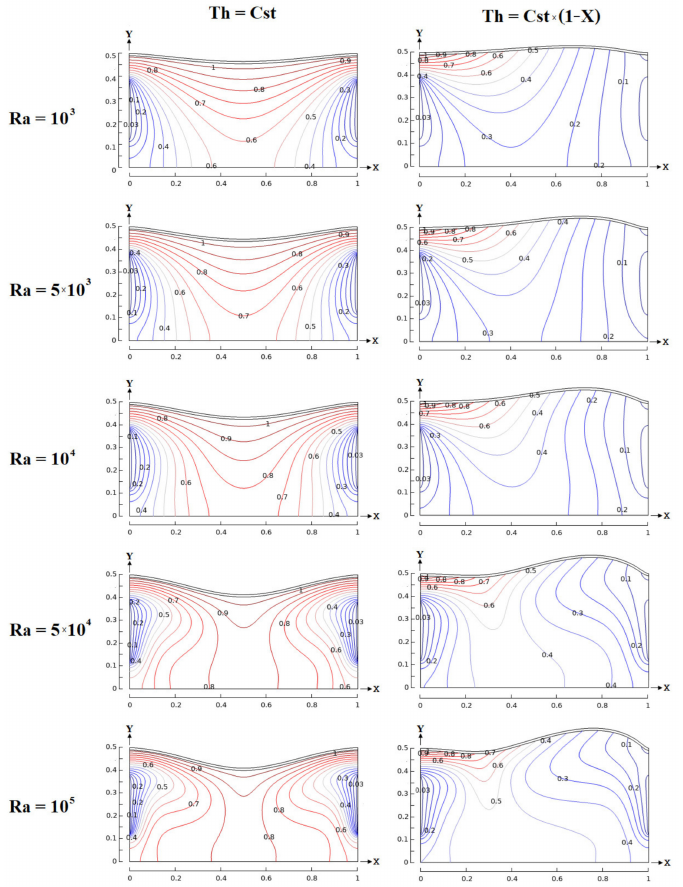
Figure 4. Combined effects of hot temperature distribution and Rayleigh number on nanofluid temperature